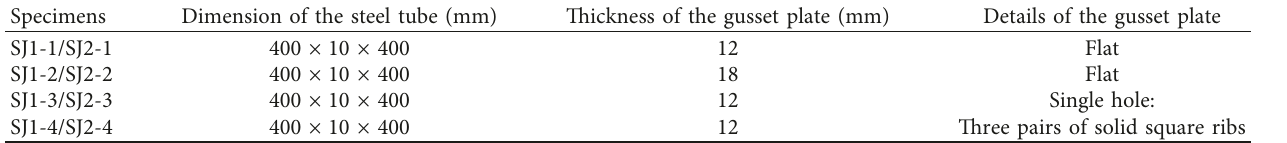
Table 1: Details of the steel tube and gusset plate.